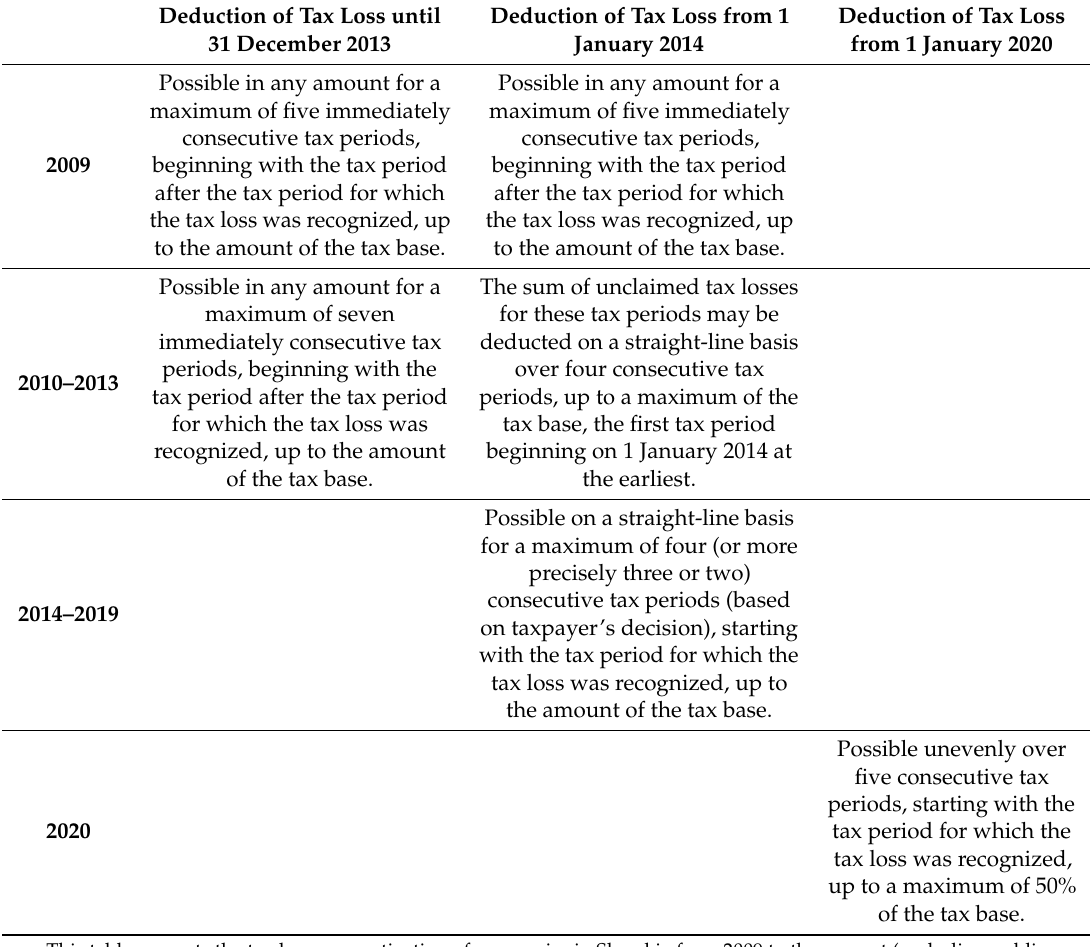
Table 2. Legislative specifics of tax loss amortization in